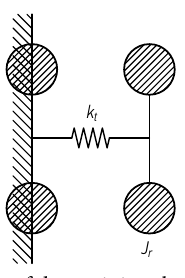
J r Fig. 6. The principle of determining the 1st eigenfrequency by fixing wheelset mass (the wheelset is blocked and the rotor oscillates)